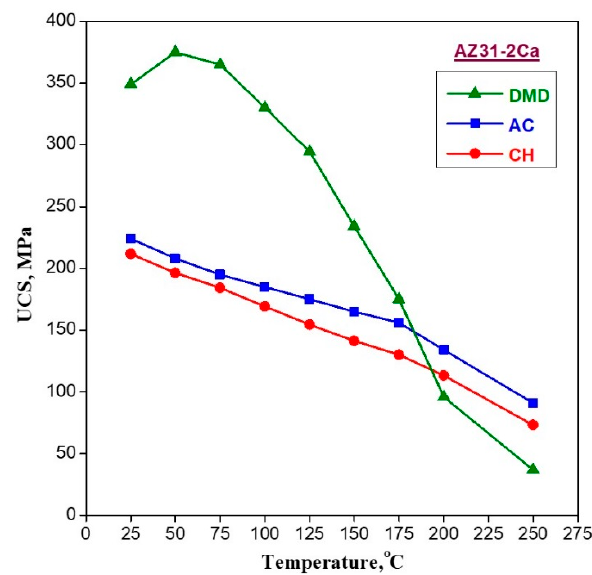
Figure 4. Ultimate compressive strength (UCS) of AZ31-2Ca alloy for DMD processed, as-cast (AC), and cast-homogenized (CH) conditions at different temperatures.